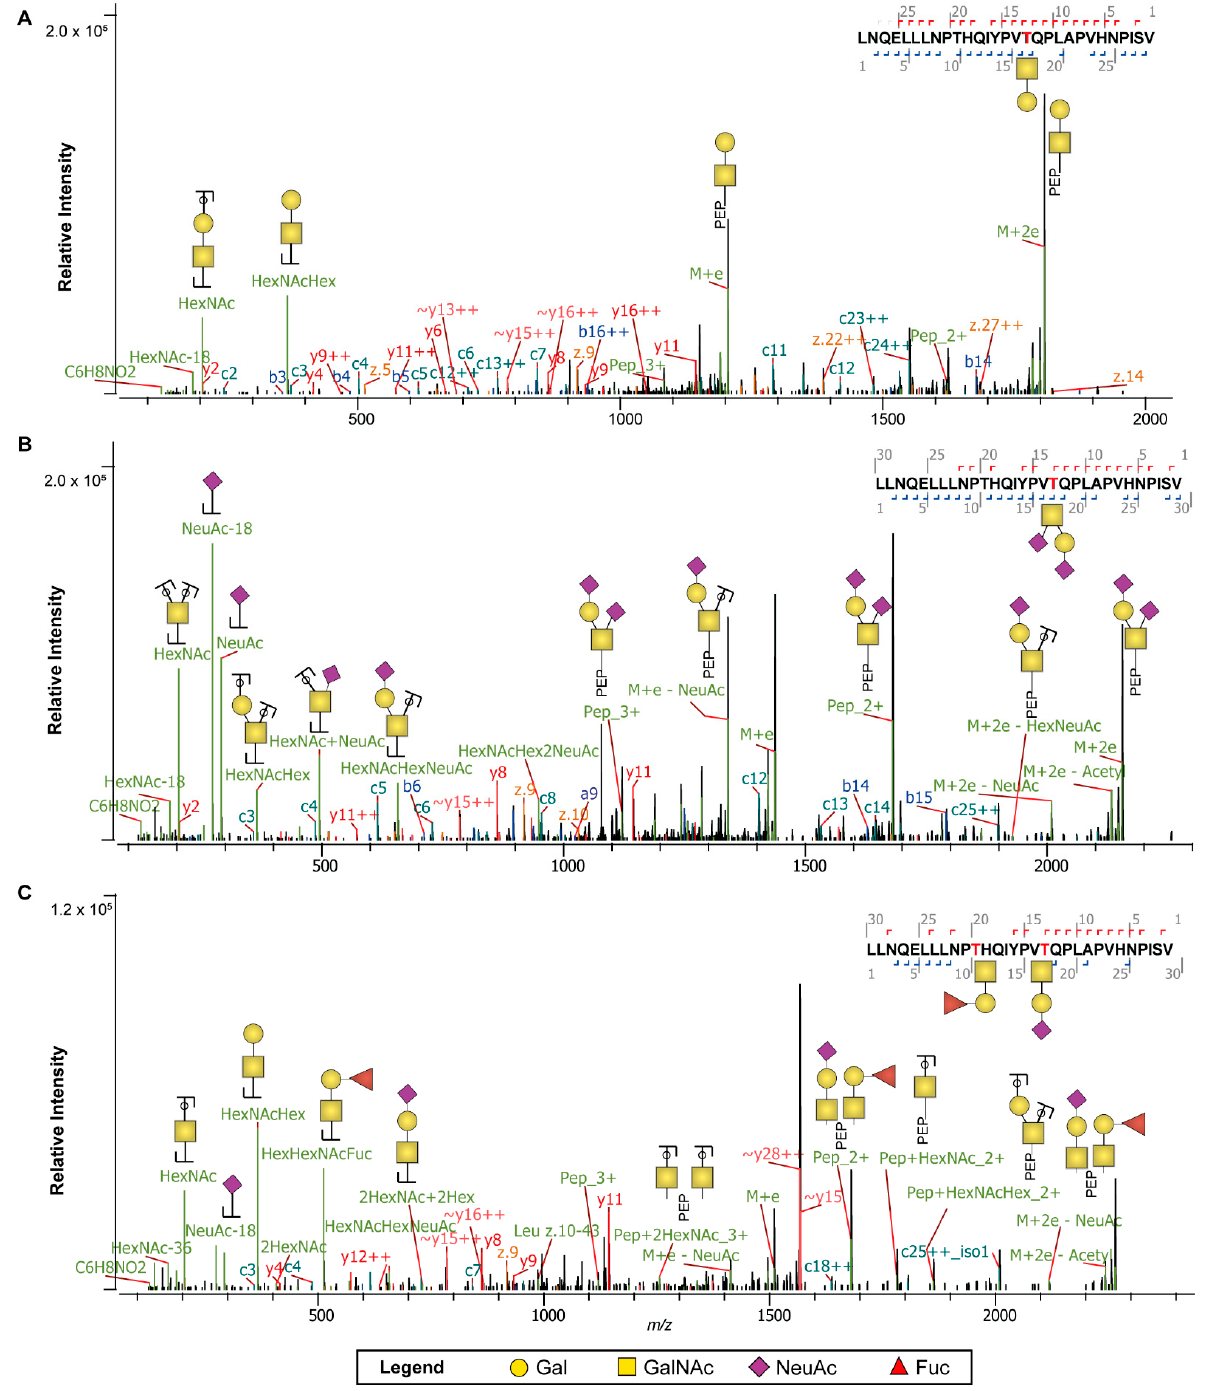
Figure 5. EThcD fragmentation spectra of the C-terminal β -casein peptide 197 LLNQELLLNPTHQYPVTQPLAPVHNPISV 226 decorated by distinct O -glycans. ( A ) EThcD spectra with the O -glycopeptide carrying N 1 H 1 glycosylation. ( B ) EThcD spectra with the O -glycopeptide carrying a sialylated glycan, N 1 H 1 S 2 . ( C ) EThcD spectra with the O -glycopeptide carrying sialylated and fucosylated glycans, N 1 H 1 S 1 and N 1 H 1 F 1 . Note that a mixture of positional isomers could have been fragmented in the presented spectra and that different glycan structures likely exist for the displayed annotations. Only major glycan fragments are annotated. The monosaccharide legend is displayed at the